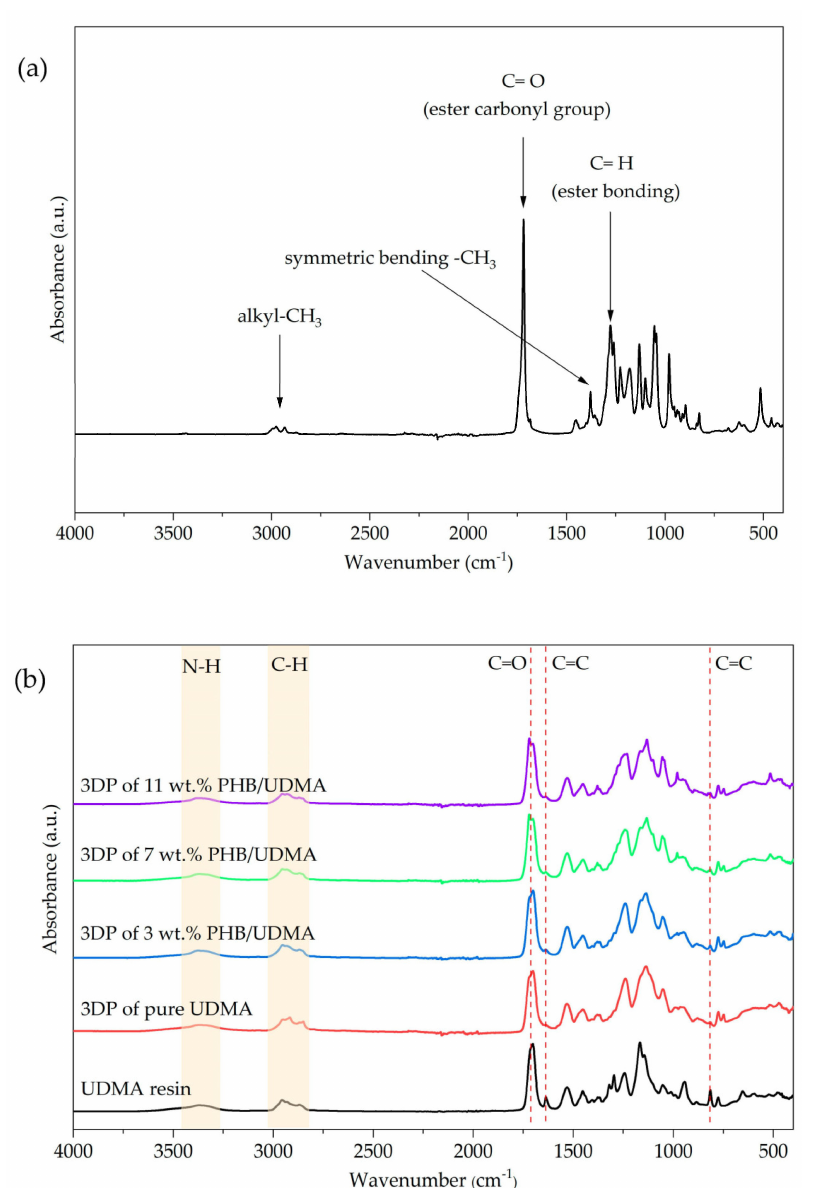
Figure 8. Infrared spectra of: ( a ) PHB powder; ( b ) UDMA resin; 3D printed UDMA and 3D printed